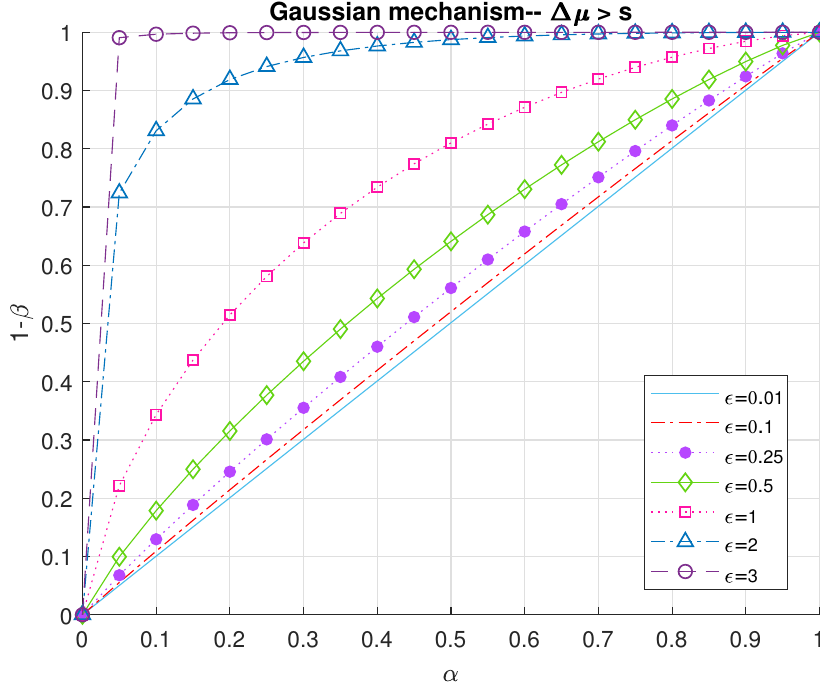
Figure 6. Equations (62) and (63) for various values of (cid:101) , ∆ µ > s and δ = (cid:101) /20.